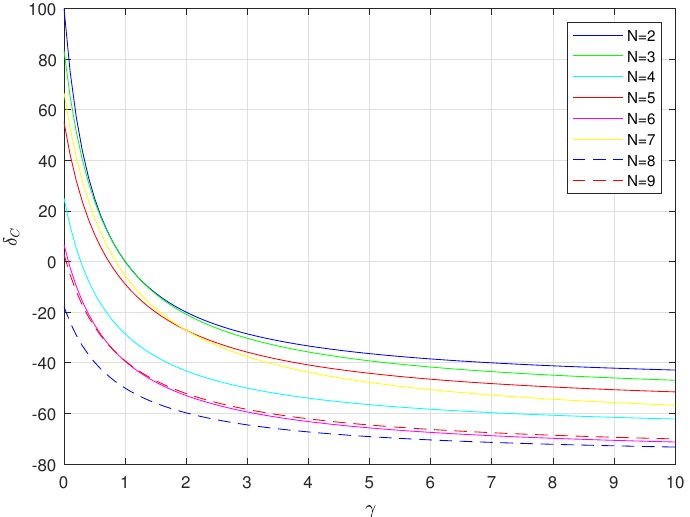
Figure 10. The value of percentage changes δ c as a function of the relative cost coefficient γ for various values of N